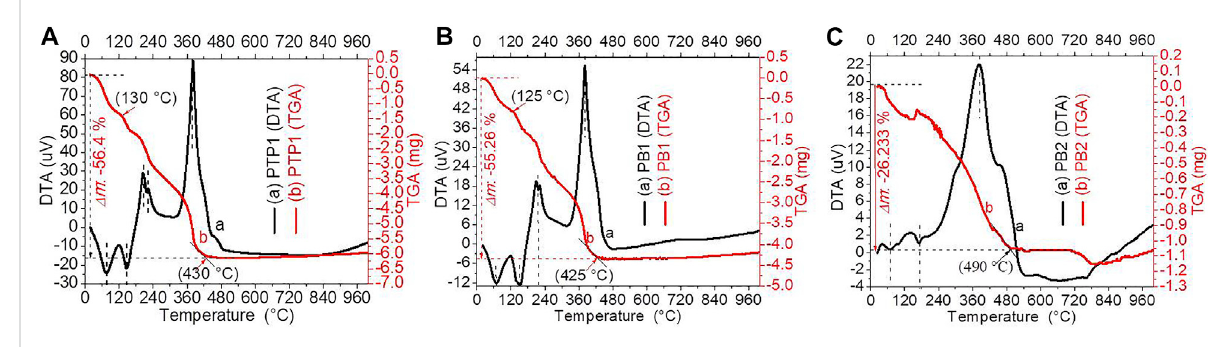
FIGURE 1 Thermal analysis: TGA/DTA plots of (A) PTP1, (B) PB1, and (C) PB2 before calcination.